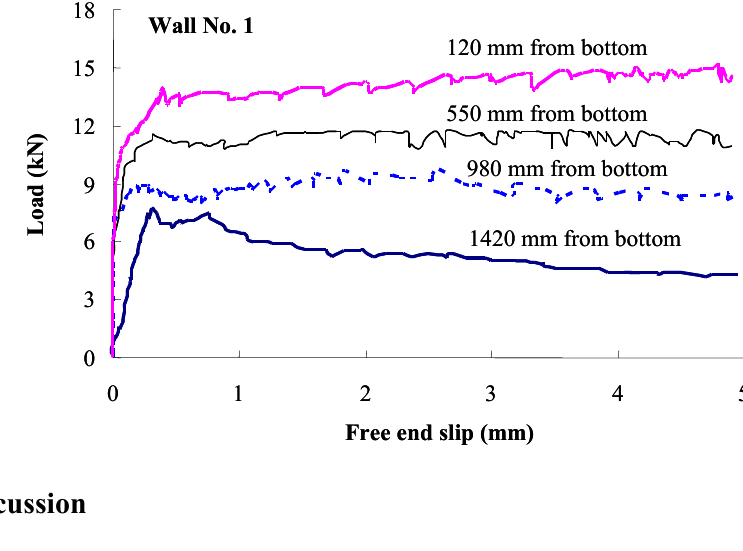
Figure 6. Pull-out load and free-end slip responses of prestressing strands embedded at different heights along wall element (Wall No. 1).